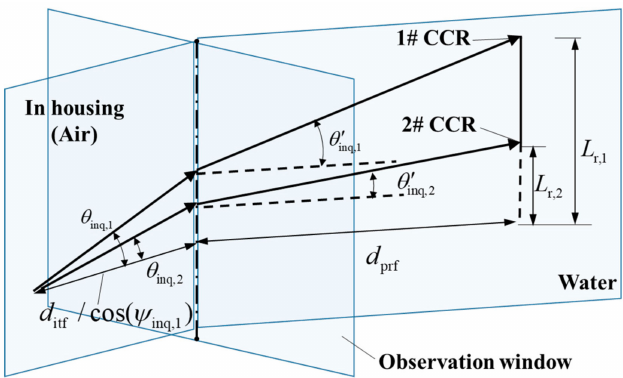
Figure 10. Schematic of the proposed triangulation ranging method, including the refraction e ff